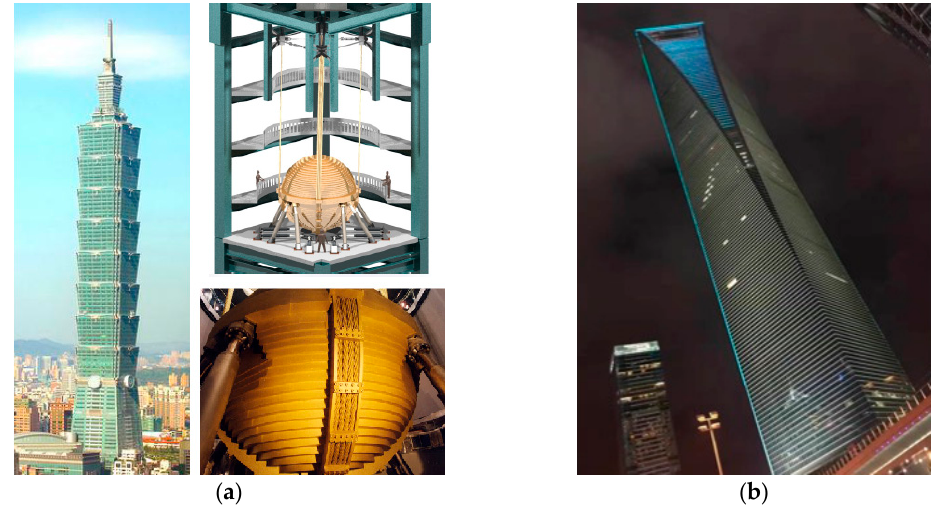
Figure 1. ( a ) Taipei 101 with a sphere-shaped tuned mass damper [3] ( b ) Shanghai World Financial Center in Shanghai, China.